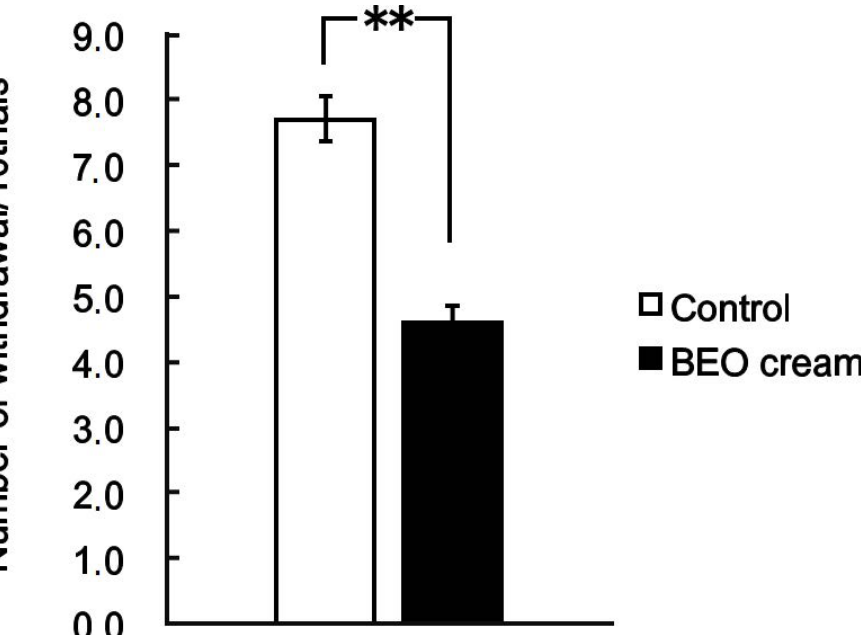
Figure 4. Antiallodynic effect of topical application of NanoBEO (1 mg/mouse) on partial sciatic nerve ligation (PSNL). Empty cream (1 mg/mouse) has been used as a control and this has failed to affect PSNL-induced mechanical allodynia. Each value represents mean ± SEM ( n = 10). Values of p < 0.05 have been considered statistically significant. Improvement over control of 58.76%, ** p <